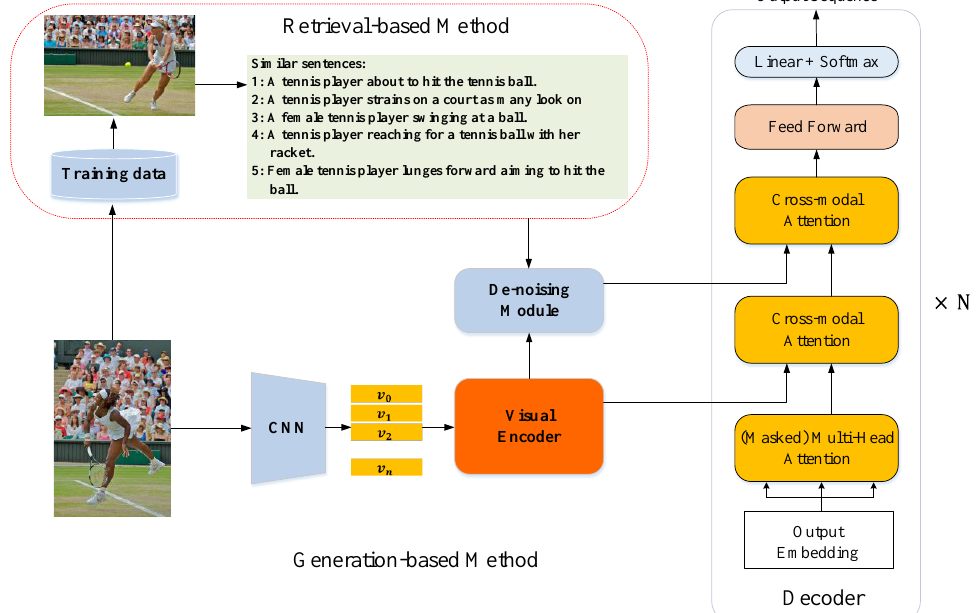
Figure 1. Our model combined the retrieval-based method and the generation-based method. The de-noising module here is used to filter the retrieved similar sequences. The decoder here used both the filtered textual features and the attended visual features to generate the final